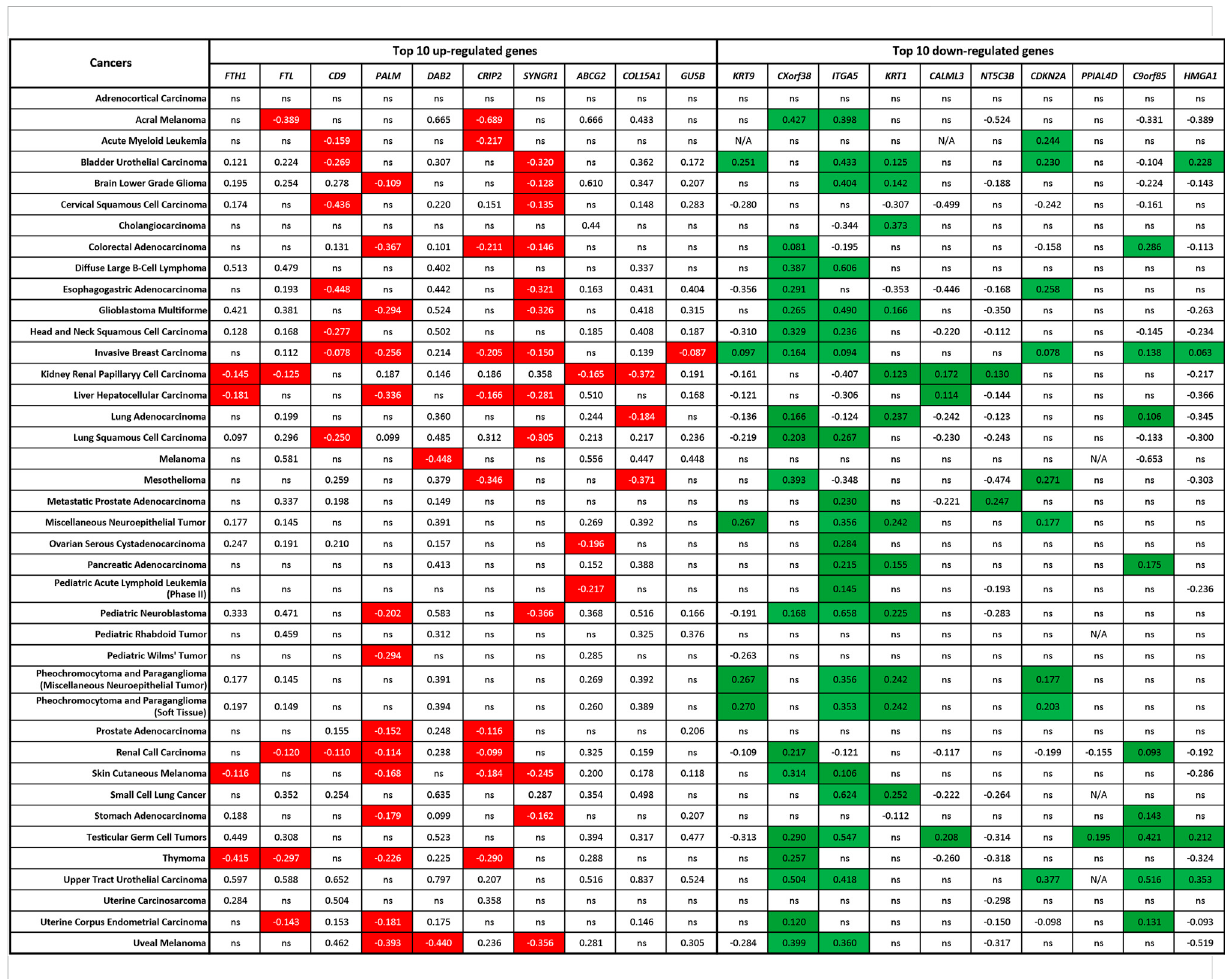
FIGURE 6 Co-expression of ZIP8 ( SLC39A8 ) and top-10 upregulated or downregulated ZIP8-KO-associated protein genes in 40 cancer types. Clinical data were obtained from TCGA database and analyzed by Spearman ’ s correlation. A Spearman ’ s correlation value greater than 0 indicates a positive correlation,andavaluelessthan0indicatesanegativecorrelation.Co-expressionsthatsignifytheproteomeofZIP8-KO werehighlighted:negative correlations betweenthe ZIP8 andupregulatedproteingenes(highlightedinred)orpositive correlations betweenthe ZIP8 anddownregulated protein genes (highlighted in green). Only values with p ≤ 0.05 were shown. N/A: data not available; ns: non-signi fi